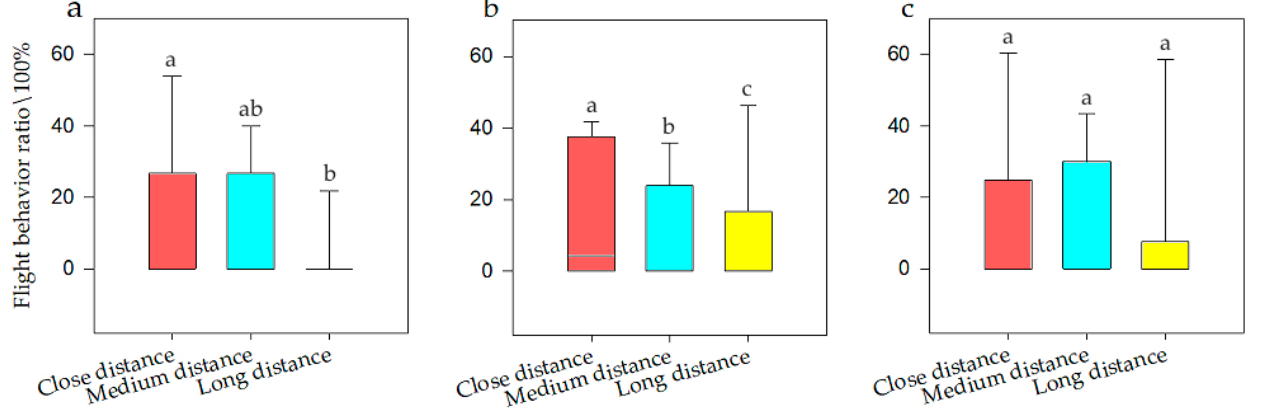
Figure 6. Flight behavior of bean geese (( a ) Population N; ( b ) Population N1; ( c ) Population N2) of close distance, medium distance, and long distance. Different letters in the graphs represent significant differences from one-way ANOVA and SNK tests. Bars represent means; error bars denote standard deviations. The bar with the highest flight behavior ratio is marked as “a”. The flight behavior ratio is compared with other interference distances, and the difference is significant, marked as “b”.